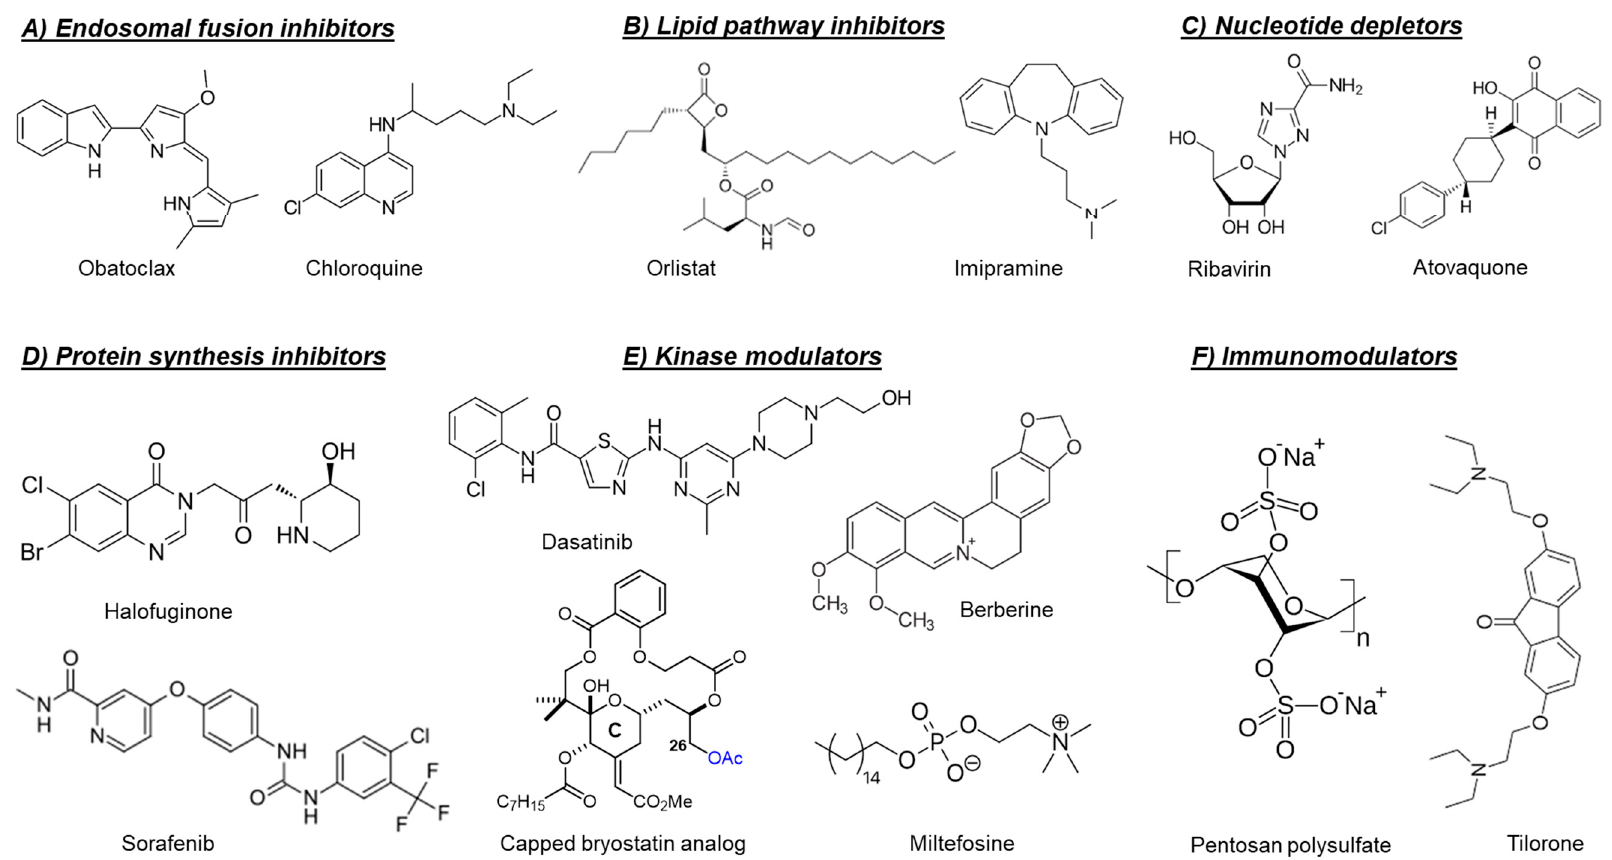
Figure 3. Chemical structures of selected host-targeting alphavirus inhibitors.